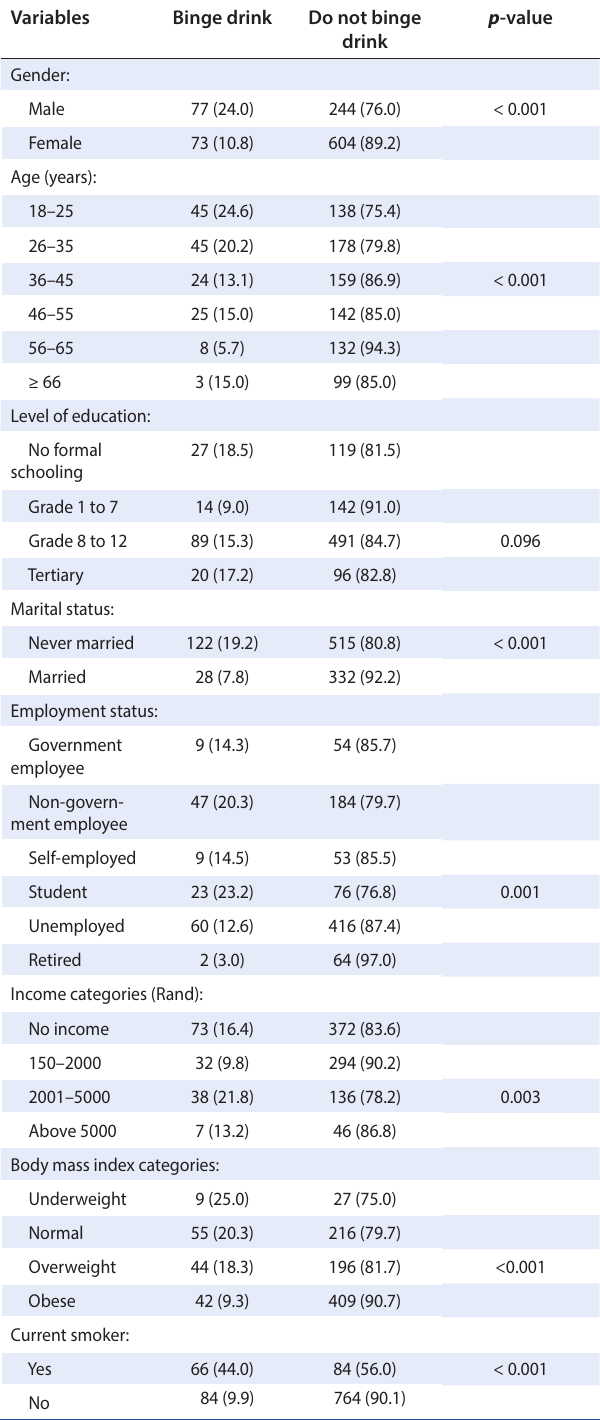
OR = odds ratio; CI = confidence interval.